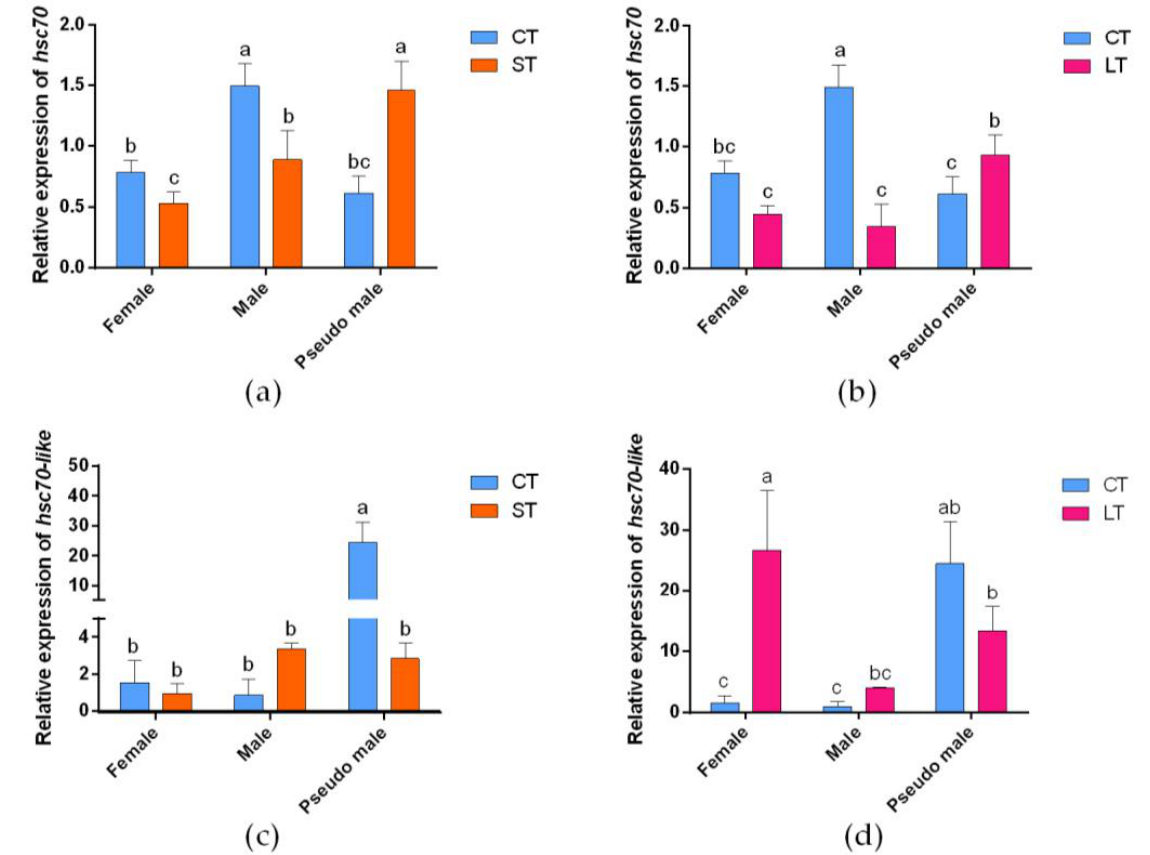
Figure 6. Gonadal expression of hsc70 and hsc70-like genes in C. semilaevis under different high-temperature treatments. ( a , b ) Expression pattern of hsc70 in the gonads of 3 mpf C. semilaevis under short-term ( a ) and long-term ( b ) high-temperature treatment; ( c , d ) Expression pattern of hsc70-like in the gonads of 3 mpf C. semilaevis under short-term ( c ) and long-term ( d ) high-temperature treatment. The expression of target genes were shown as means ± SEM ( n = 3). β -actin as the internal control. CT, control treatment; ST, short-term heat stress treatment; LT, long-term heat treatment. Different letters indicated statistically significant differences ( p < 0.05).